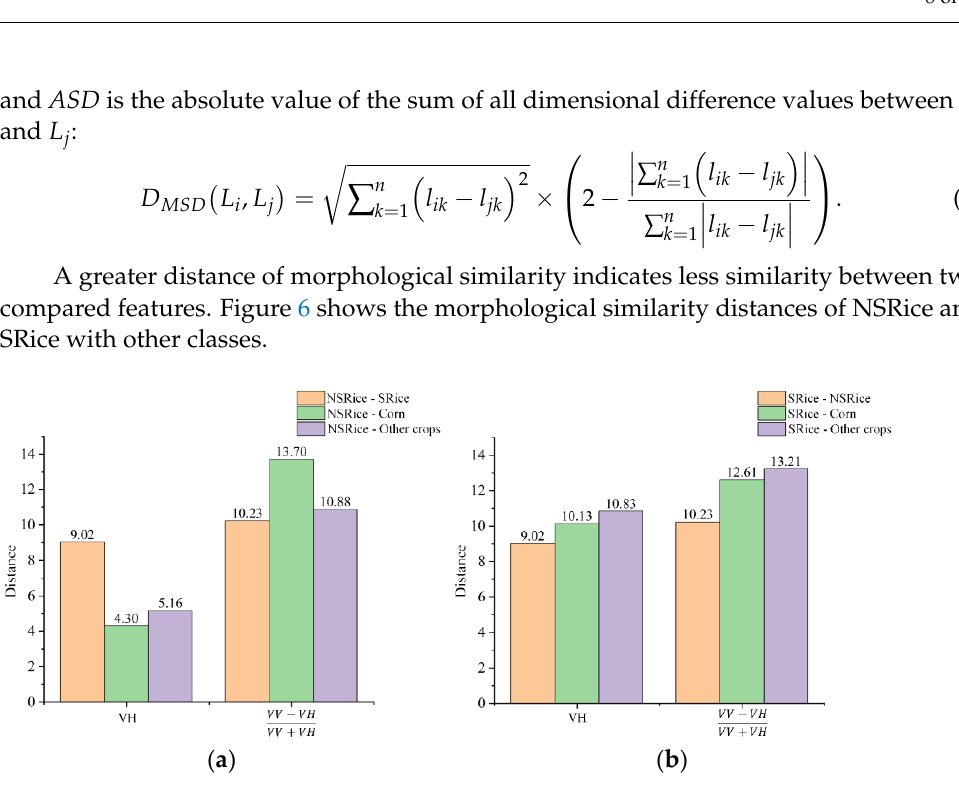
Figure 6. Morphological similarity distances between rice and other crops: ( a ) distances between NSRice and SRice, corn and other crops; ( b ) distances between SRice and NSRice, corn and other crops.